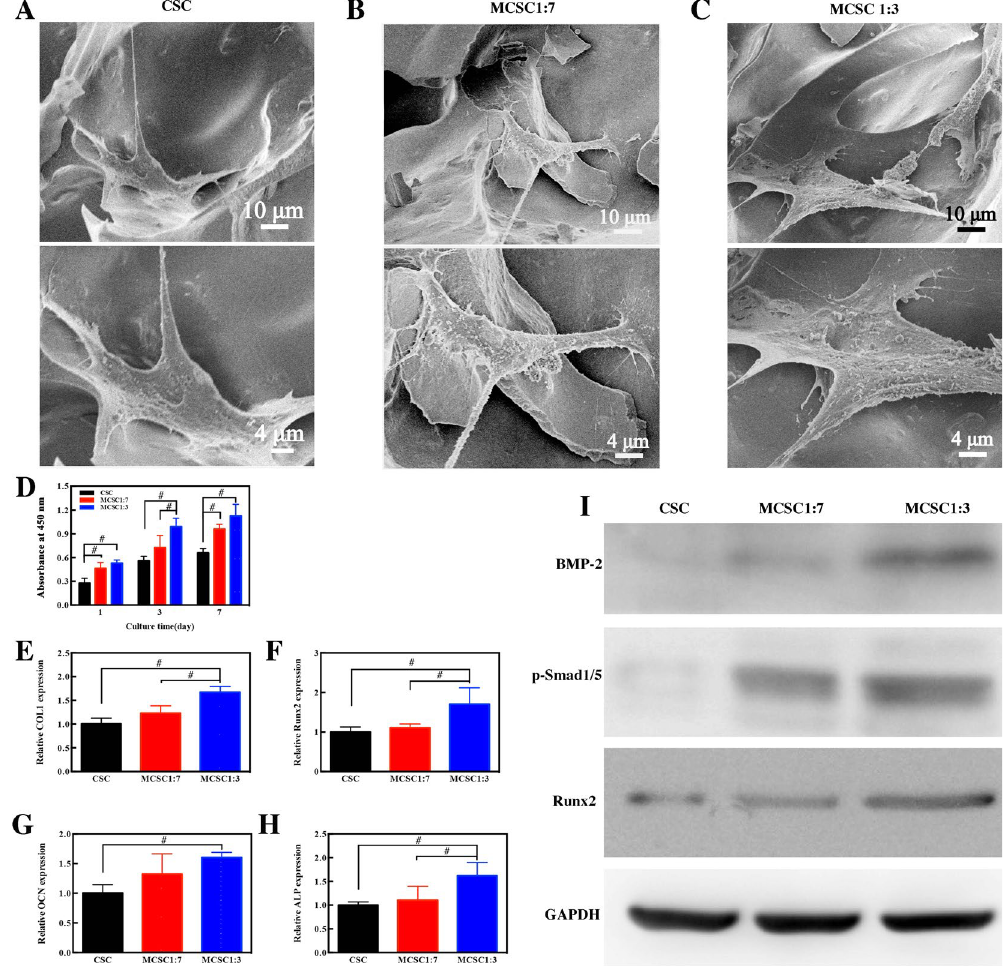
Figure 8. The hBMSCs seeded scaffolds promoted osteogenesis in vitro . Representative SEM images of hBMSCs cultured on CSC ( A ), MCSC 1:7 ( B ) and MCSC 1:3 ( C ) scaffolds for 3d. ( D ) The cell proliferation of hBMSCs and the osteogenic gene expression of ( E ) COL 1, ( F ) Runx2, ( G ) OCN and ( H ) ALP) at mRNA level in hBMSCs cultured on CSC, MCSC 1:7 and MCSC 1:3 scaffolds for 14 days. ( I ) The expression of BMP-2, p-Smad1/5, and Runx2 at the protein level in hBMSCs cultured on CSC, MCSC 1:7 and MCSC 1:3 scaffolds for 14 days. # p <